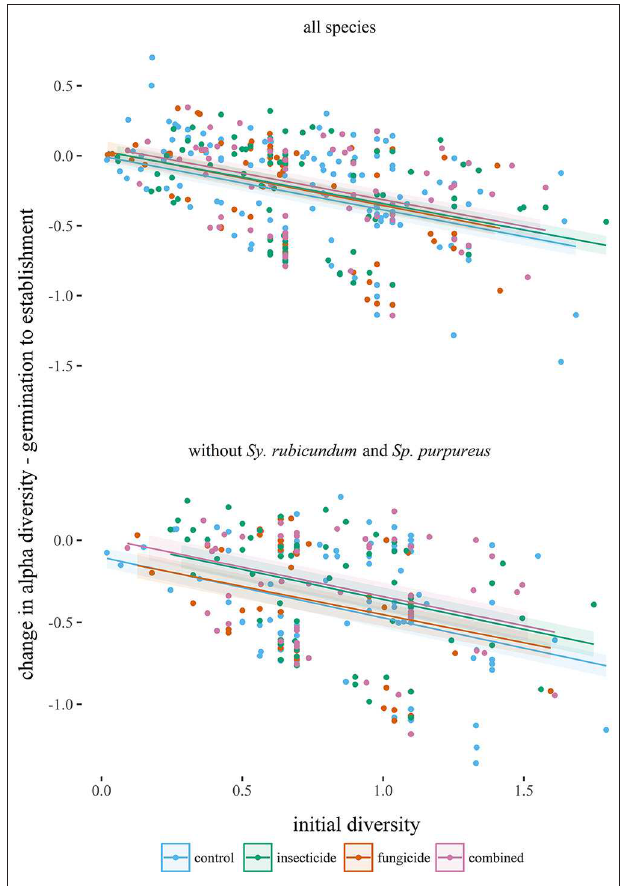
FIGURE 2 | Changes in alpha diversity (Shannon index) of seedling assemblages (from germination to establishment) plotted against initial diversities of seedlings (1 m 2 plots) in each experimental treatment. Lines are predicted from linear mixed effects models ( Table 1 ) and are plotted with standard